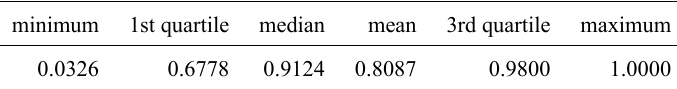
Descriptive statistics. minimum 1st quartile